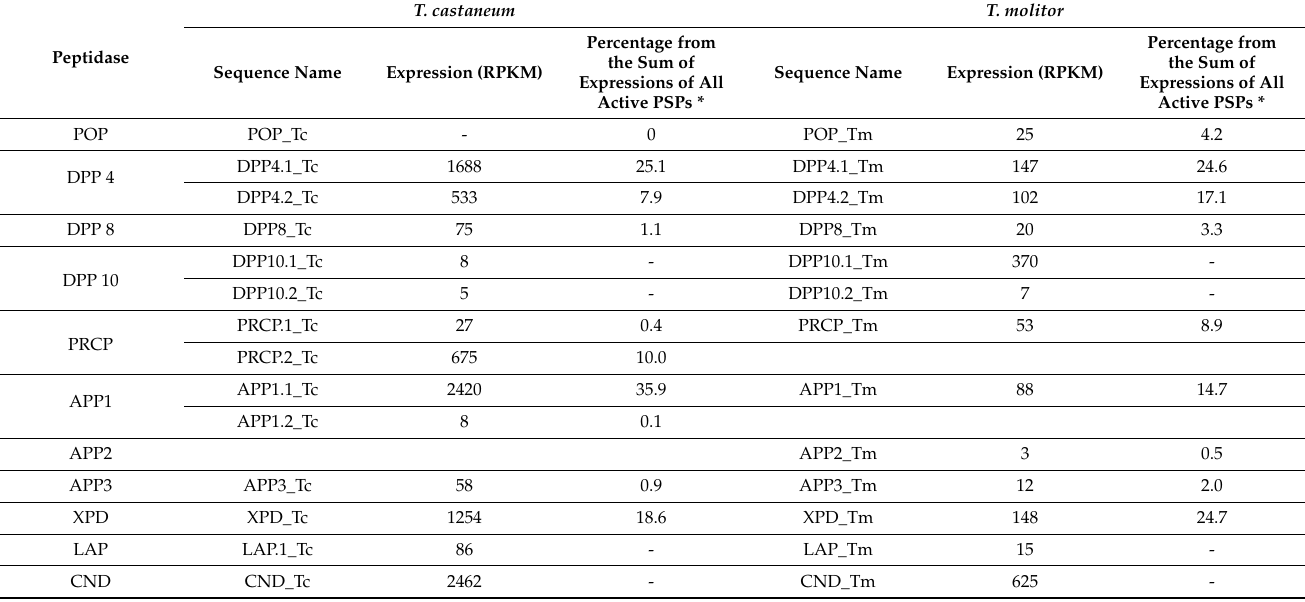
Table 7. Gut mRNA expression levels of T. castaneum and T. molitor PSPs and